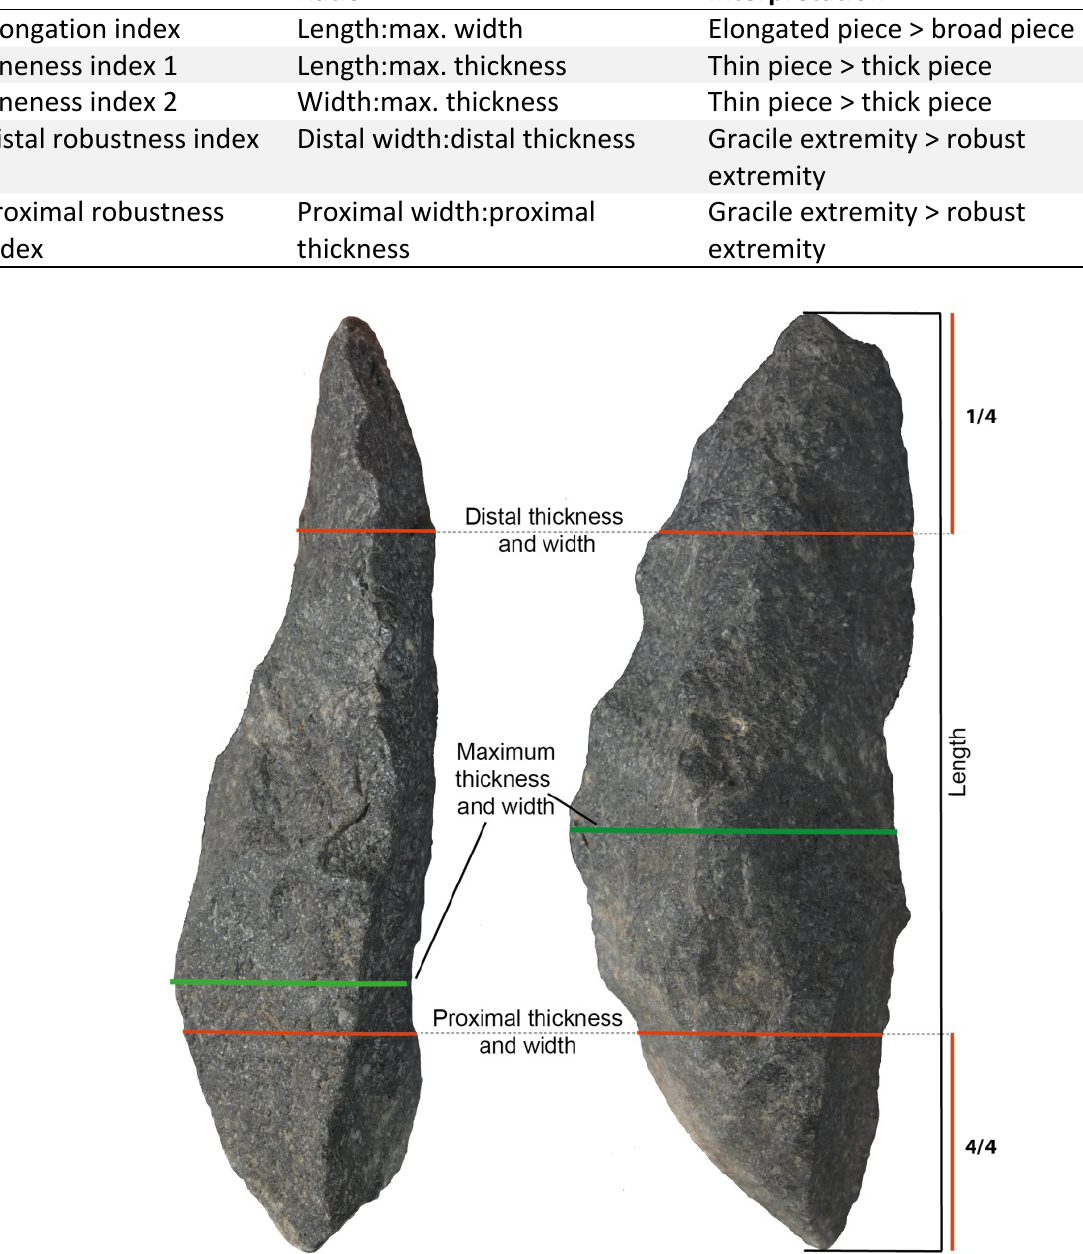
Figure 6. Description of the linear measurements on a piece from N’Zako Ambilo (NZA). Distal thickness and width have been measured at ¼ of the length from the distal end, and proximal thickness and width at the ¾ of the length from the distal